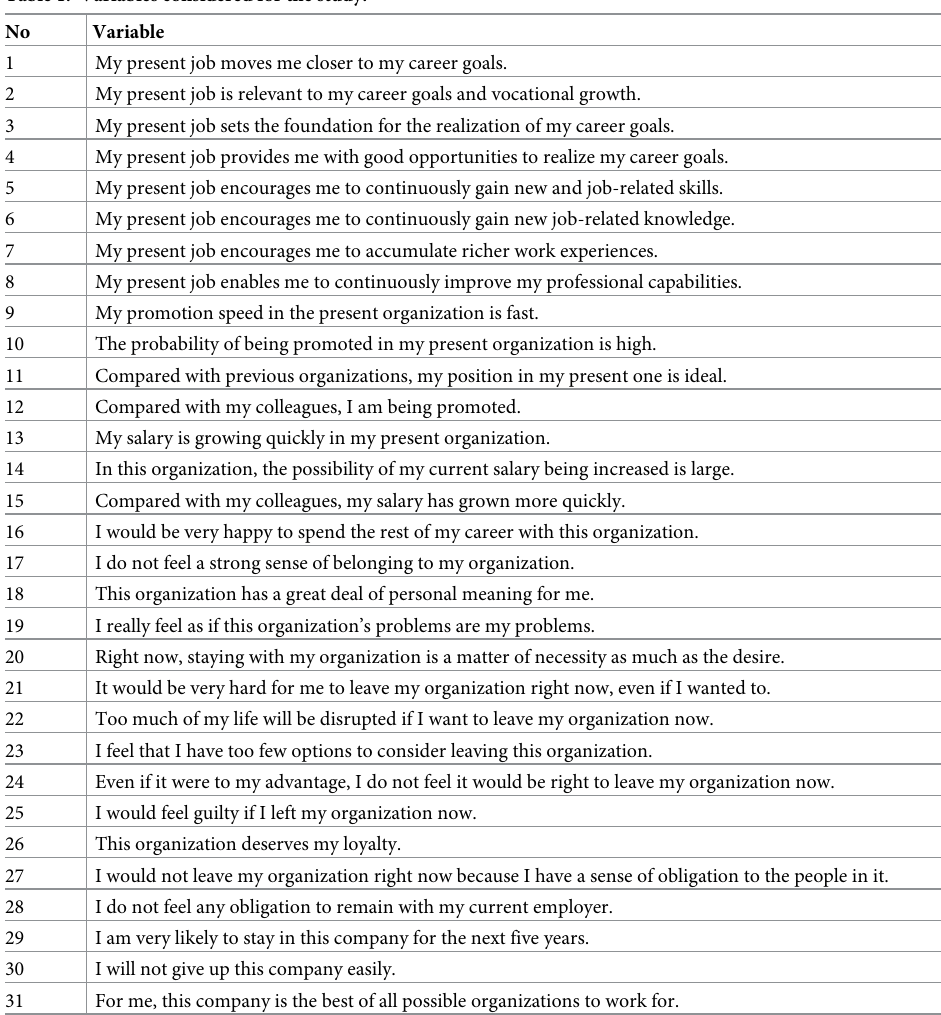
Table 1. Variables considered for the